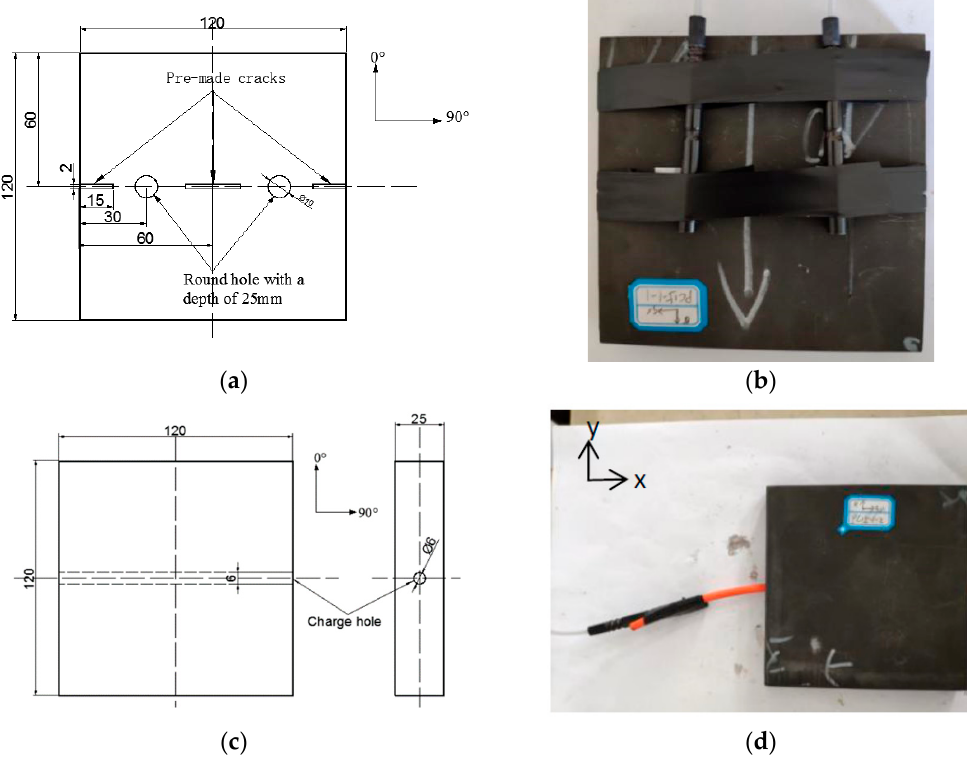
Figure 1. Schematic diagram and charge structure of the normal opening and lateral opening of the composite plate. ( a ) Schematic diagram of the normal opening of the composite plate; ( b ) Normal opening charge structure; ( c ) Schematic diagram of the lateral opening of the composite board; ( d ) Lateral opening charge structure.